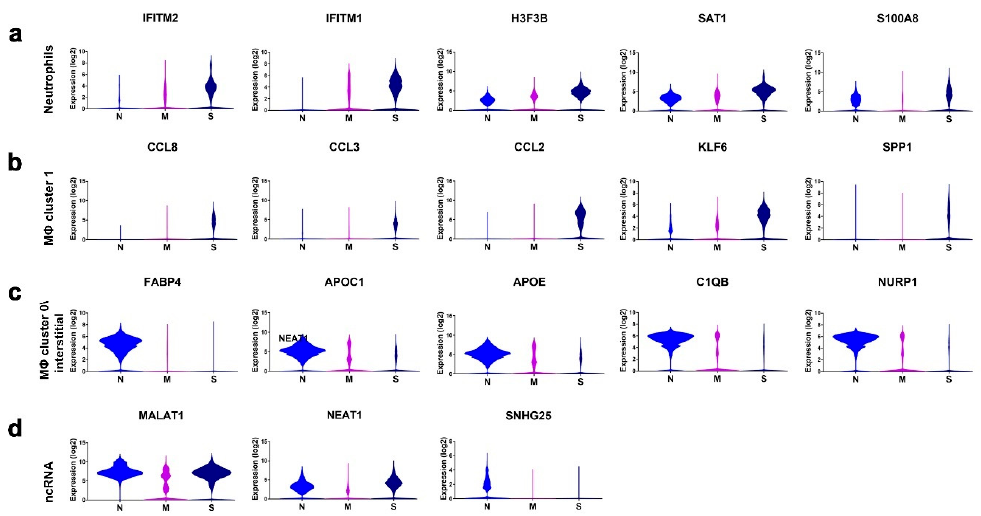
Figure 5. Expression of enriched gene markers in patients with mild or severe COVID-19 compared to healthy subjects. Expression of gene signatures derived from neutrophils ( a ), macrophage (M Φ ) cluster 1 ( b ), macrophage cluster 0/interstitial ( c ), and noncoding RNAs (ncRNA) ( d ) in a total of 68,873 single cells derived from two healthy subjects, three patients with mild COVID-19, and five patients with severe COVID-19. Data are presented as violin plots. N: control, M: mild, S: Severe. Statistical analysis revealed significant differences in gene expression ( p ≤ 0.0001) when comparing S vs. M, S vs. N, and M vs. N for the indicated genes.